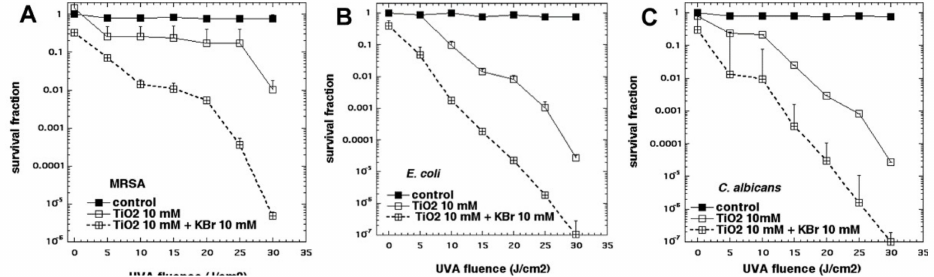
Figure 12. Titanium dioxide photocatalysis is potentiated by potassium bromide. ( A ) MRSA; ( B ) E. coli ; ( C ) C. albicans . Figure adapted from data contained in